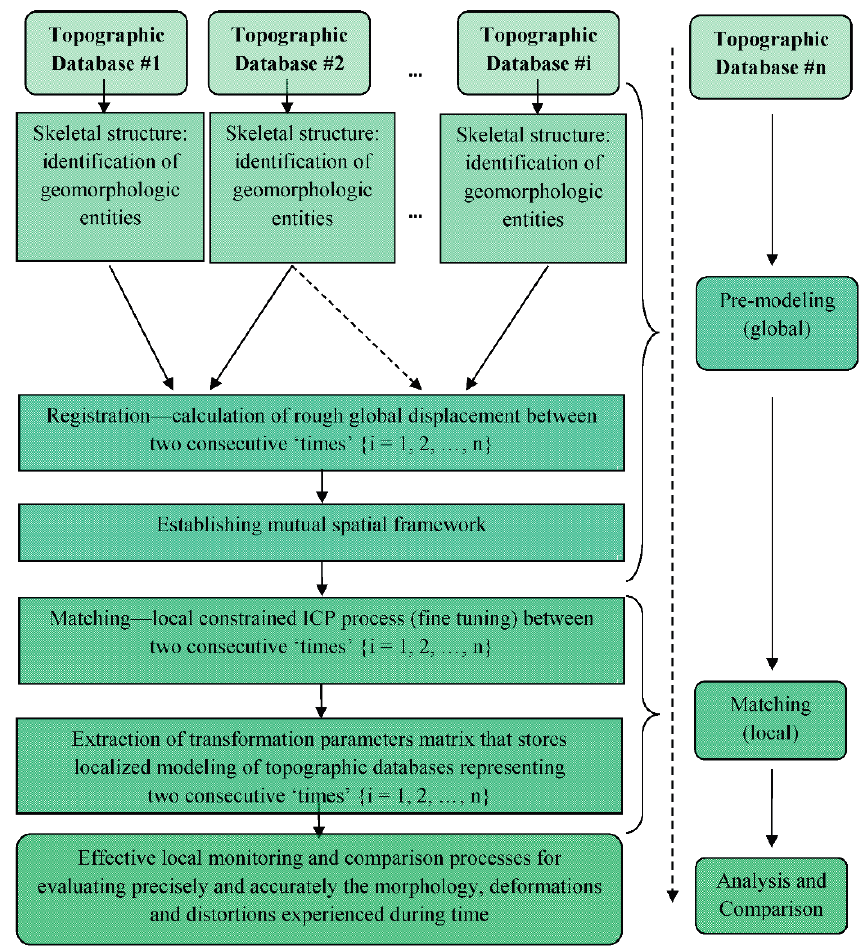
Figure 3. Block diagram of the proposed time-series hierarchical comparison